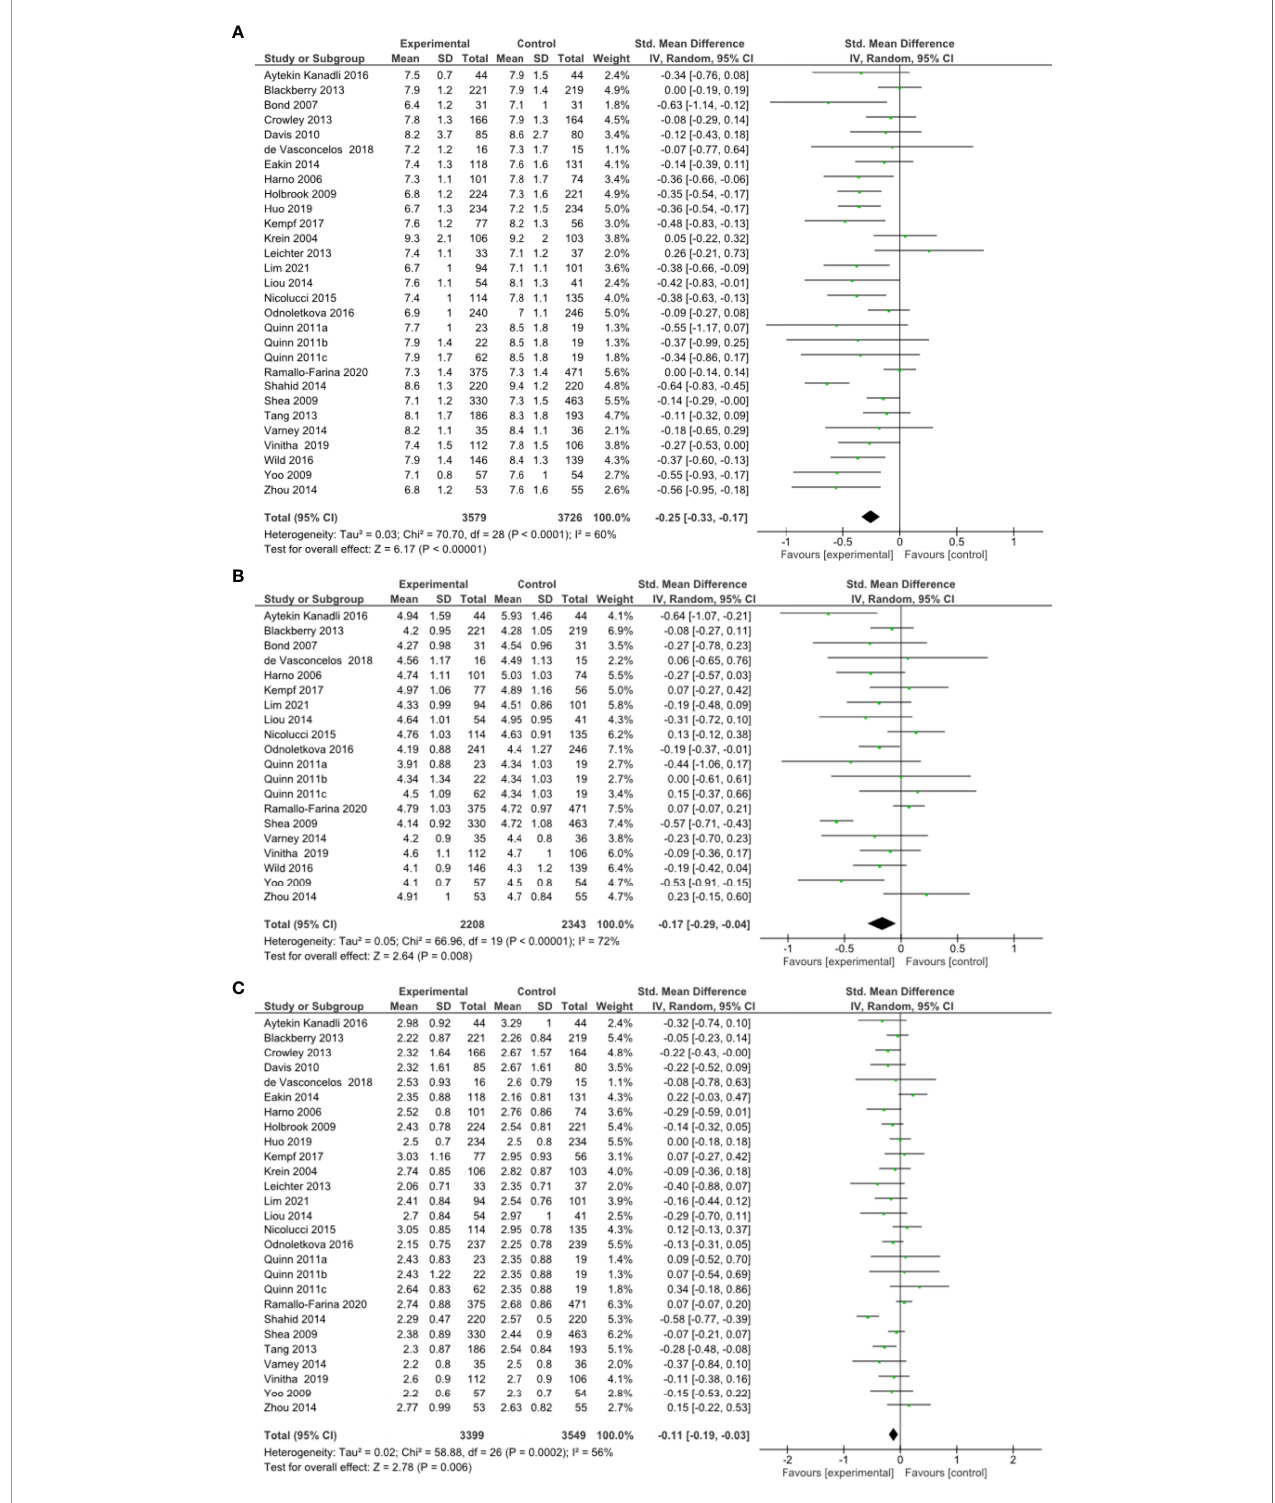
FIGURE 2 | (A) Forest plot showing the effect of remote risk factor management on HbA1c, (B) Forest plot showing the effect of remote management on total cholesterol, (C) Forest plot showing the effect of remote risk factor management on